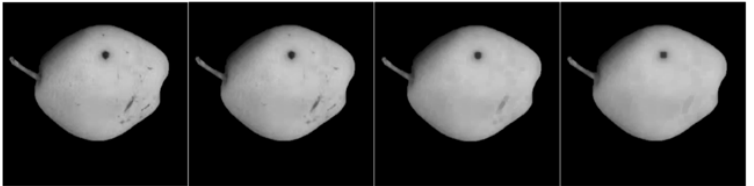
Figure 4. Image comparison before and after the opening operation of the defective pear (kernel coefficients are 1, 3, 6, 9